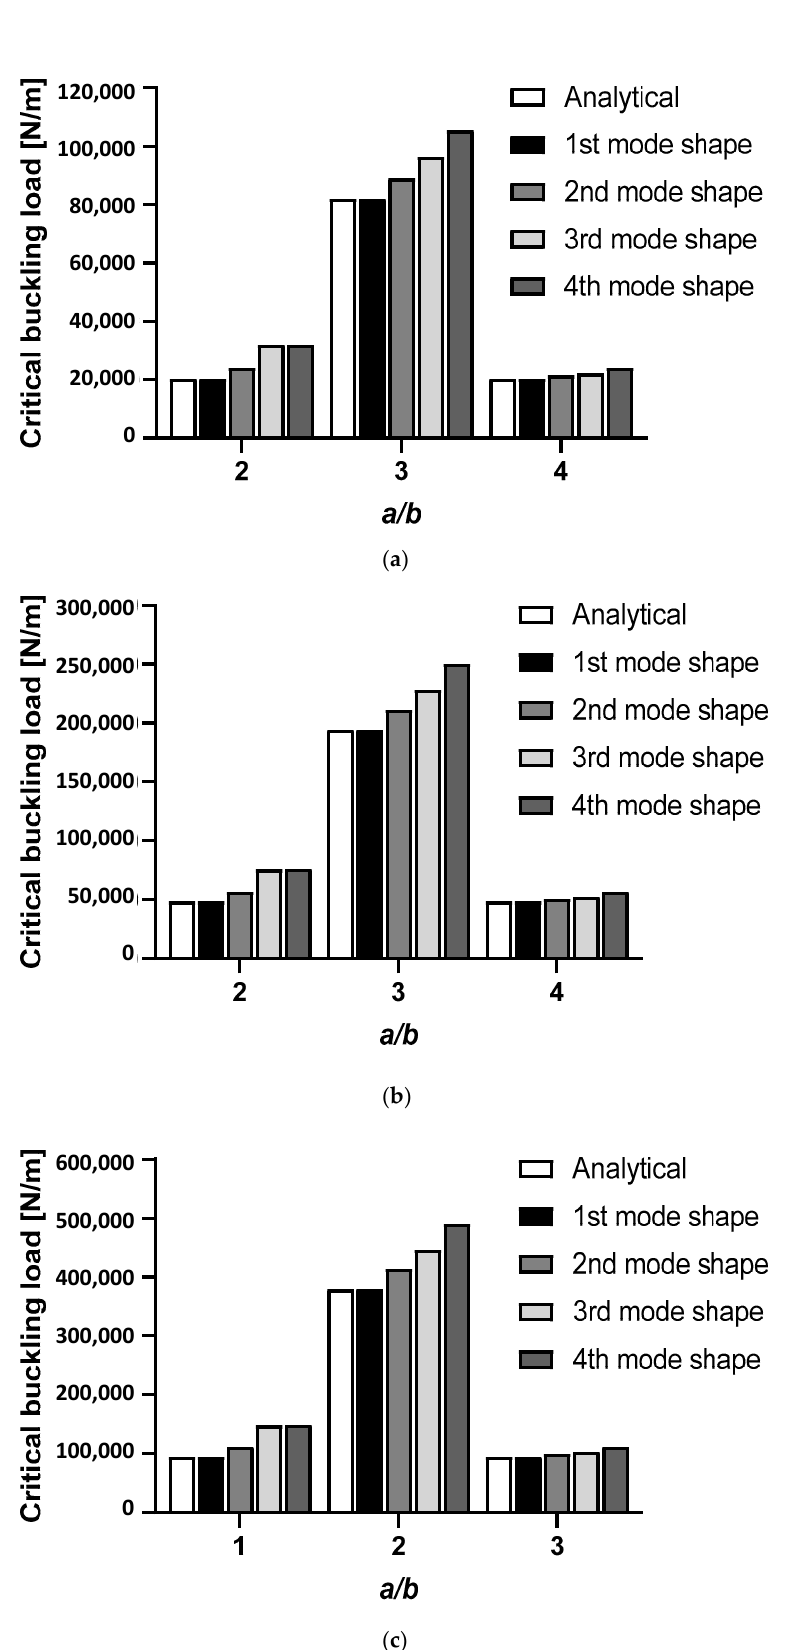
Figure 17. Effect of the a / b ratio obtained from the 3 mm thickness of the plate on the critical buckling load: ( a ) 3 mm plate thickness; ( b ) 4 mm plate thickness; ( c ) 5 mm plate